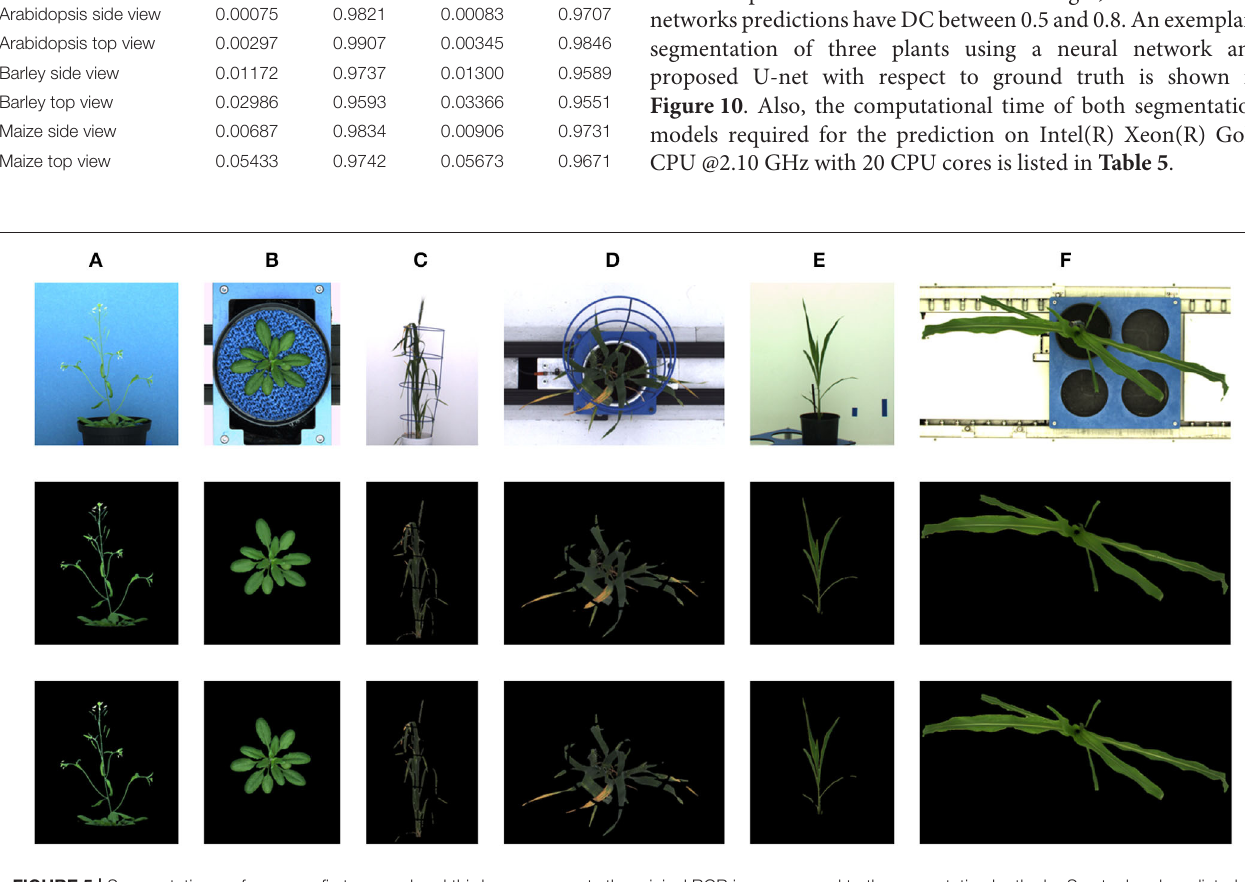
Frontiers in Plant Science |